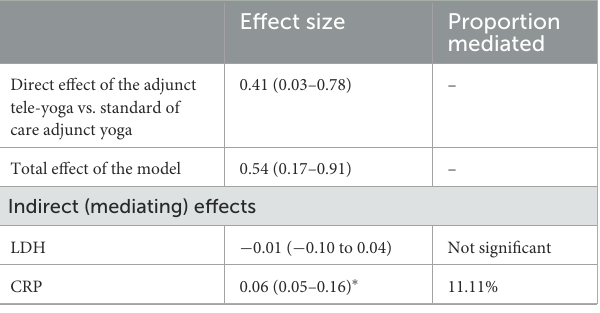
TABLE 2 Indirect, direct, and total effects of the mediation models on COVID-19 outcomes at 14-day post-randomization. Effect